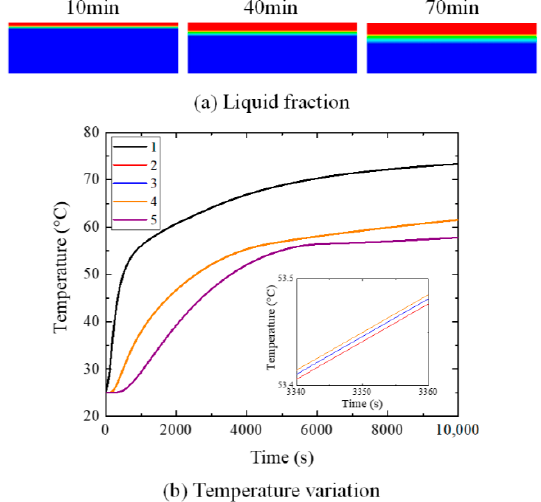
Figure 15. The melting process of paraffin with top horizontal heating (180 ◦ ). ( a ) Liquid fraction; ( b ) temperature variation.